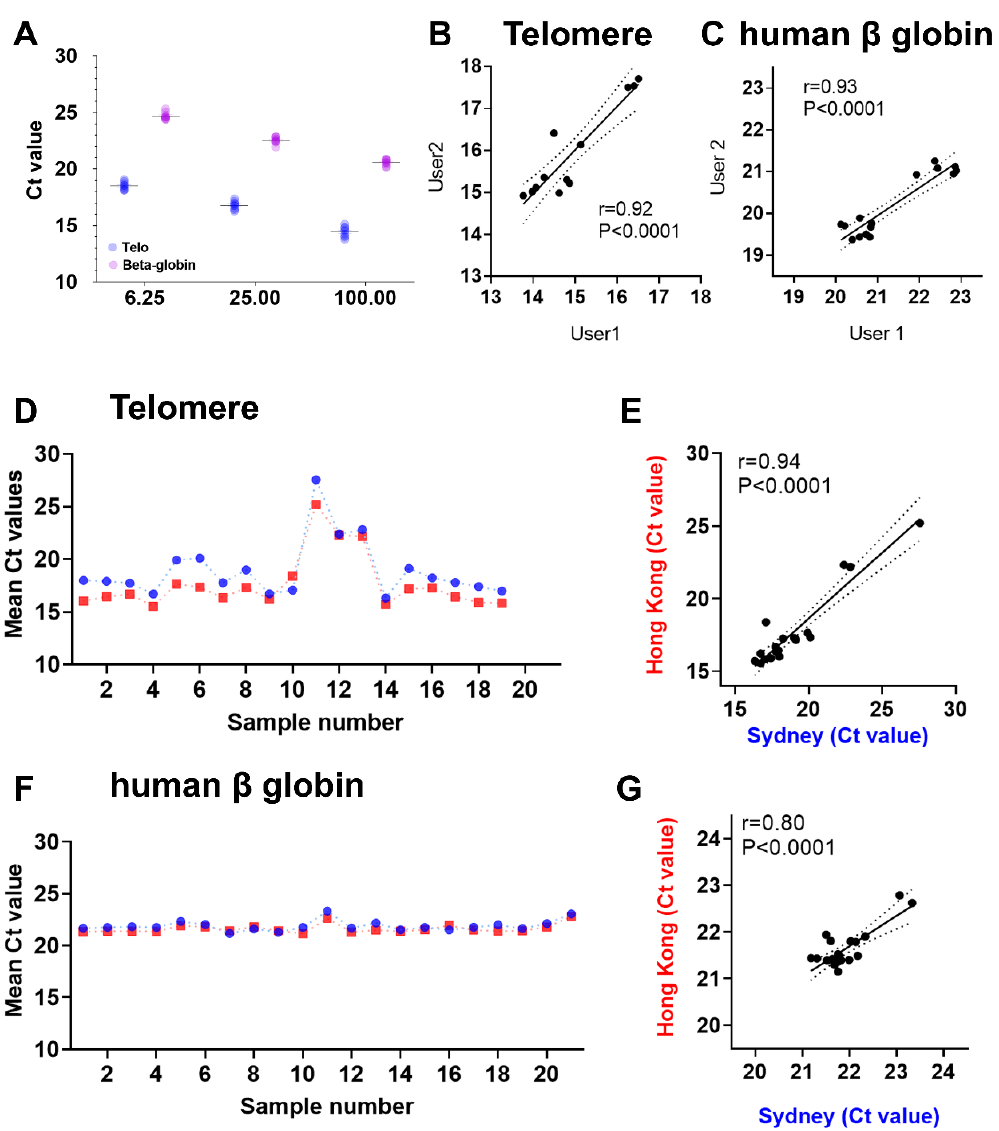
Figure 4. Reproducibility of data: the actual cycle threshold (Ct) values for the three different dilutions (100 ng/μL, 25 ng/μL, 6.25 ng/μL) used in the qPCR reactions for telomere and human β-globin expression from three technical repeats and three biological samples ( A ). PCR data from the same set of samples were obtained by two different users from the same lab, and the correlation between their results are plotted for telomere ( B ) and the human β-globin gene ( C ). Reproducibility of the method across two different labs (Sydney; Blue circles and Hong Kong; Red squares) is presented as mean Ct values of the triplicates obtained after telomere qPCR ( D ) and human β-globin qPCR ( F ). Correlation plots for telomere qPCR data ( E ) and human β-globin qPCR data ( G ) performed in each lab on the same samples. B,C,E, and G show Pearson (r) correlation coefficient and p-values.